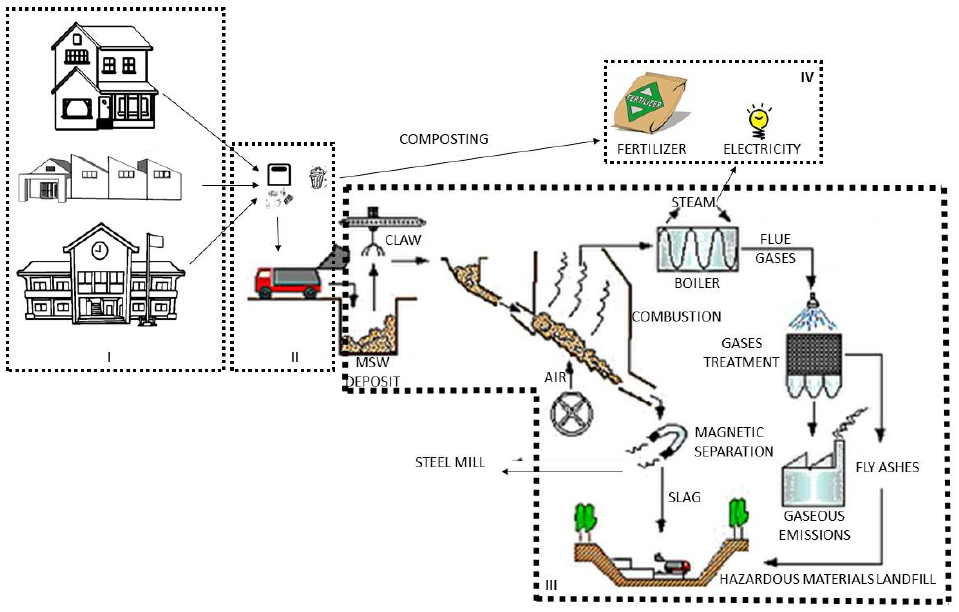
Figure 1. Integrated waste management system operated at the Greater Porto area, ▪ ▪ ▪ ▪ ▪ (bold dashed lines) representing the chosen boundary for this study.